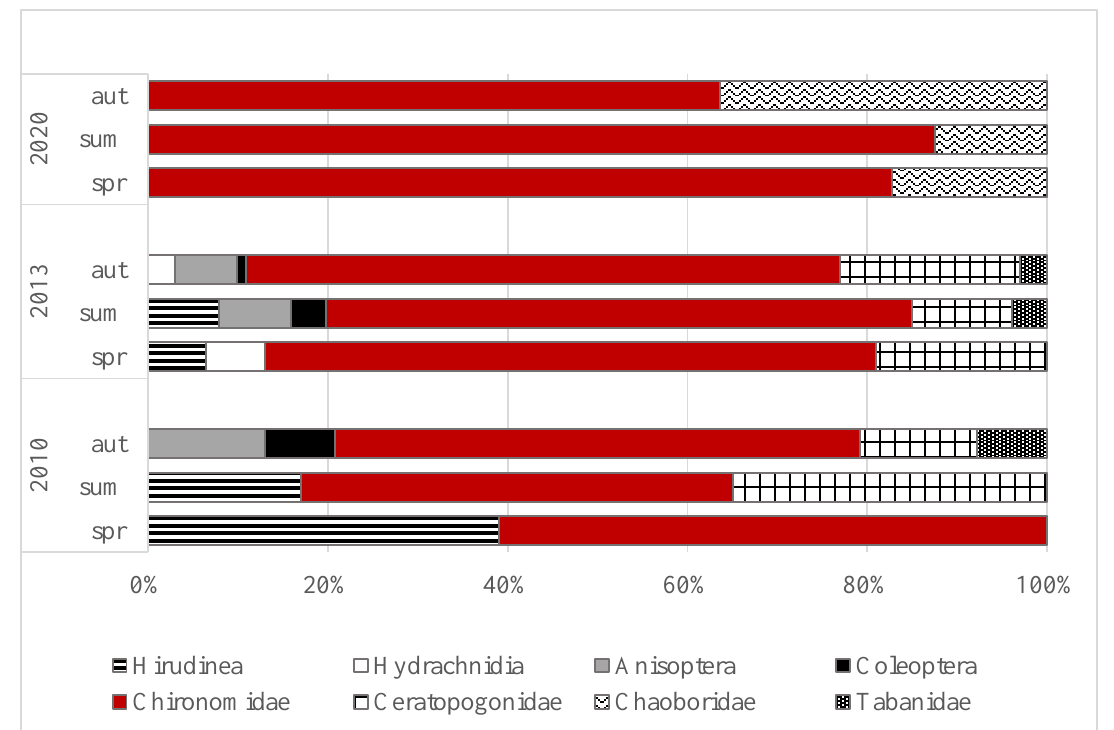
Figure 1. Seasonal changes of mean densities (±SD) of macroinvertebrates in peat pool habitat during 10 years of study.